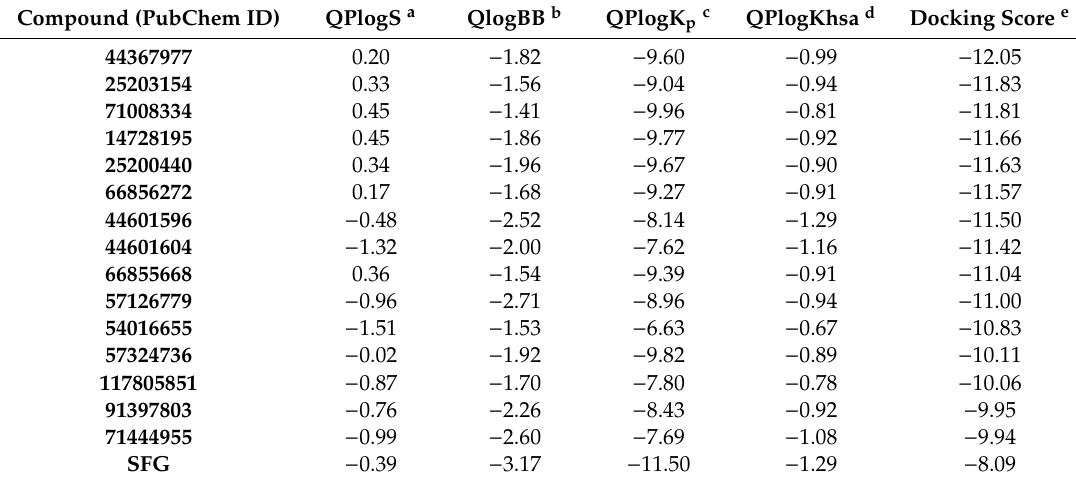
Figure 8. Chemical structure of newly identified NSP16 inhibitors from the HTVS. Table 1. Physicochemical descriptors of selected compounds from the HTVS computed with QikProp and Glide docking score.